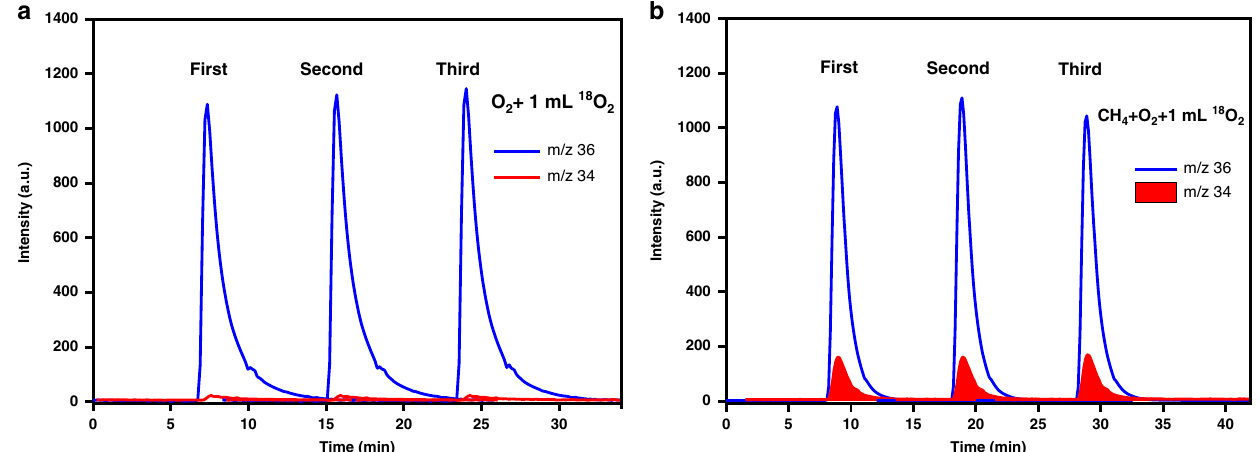
Fig. 3 Isotopic assessment of O 2 activation on supported B 2 O 3 catalysts. Mass spectra of 16 O 18 O ( m / z = 34) species upon pulsing 18 O 2 ( m / z = 36) into 16 O 2 fl ows on 20 wt% B 2 O 3 /Al 2 O 3 were collected in the a absence and b presence of CH 4 (CH 4 1 mL/min, O 2 5 mL/min, N 2 4 mL/min, temperature: 550 °C, catalyst loading: 0.2 g). In both a and b , the red and blue curves denote the signals for the m/z ratios of 34 and 36,